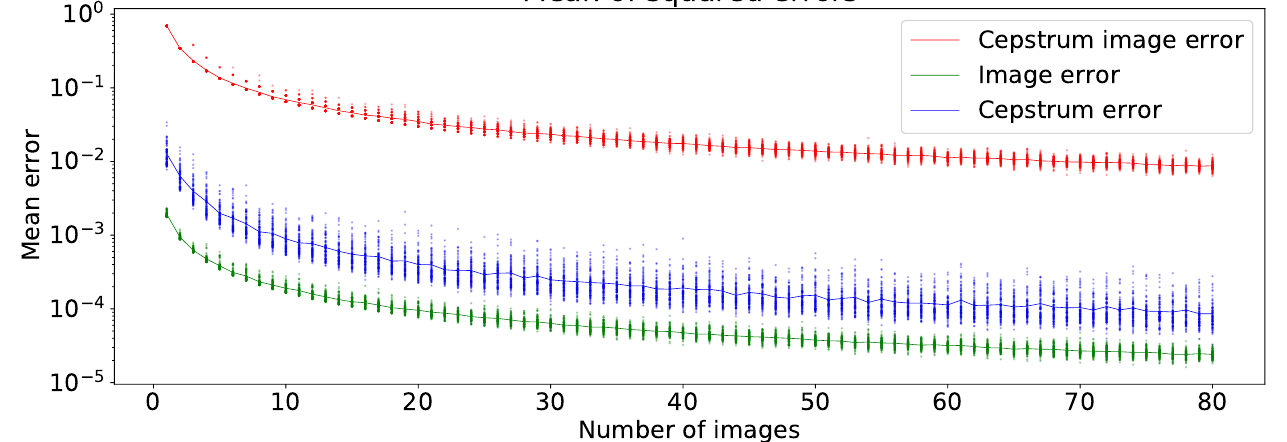
Figure 4. Cepstrum profile and cepstrum image mean-squared errors as a function of the number of cepstrum images from which the mean cepstrum image is computed. The error is the difference between the mean cepstrum image compared to the the mean cepstrum image computed from 140 cepstrum images, i.e., the proxy ground truth. The cepstrum profile error (labeled cepstrum error) is significantly smaller than the cepstrum image